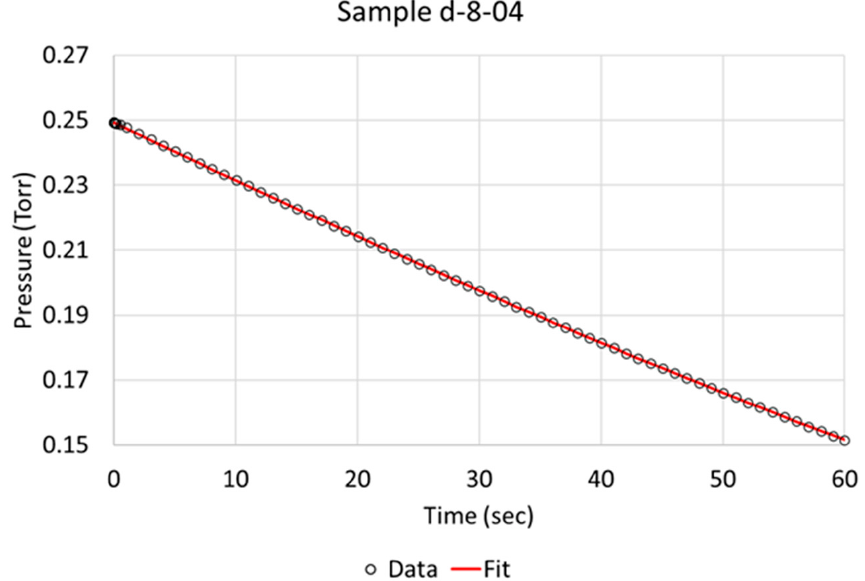
Figure 4. Berkeley Madonna fit of model to observed data indicated by circles for NPG sample d-8-04 (pretreated and activated) .